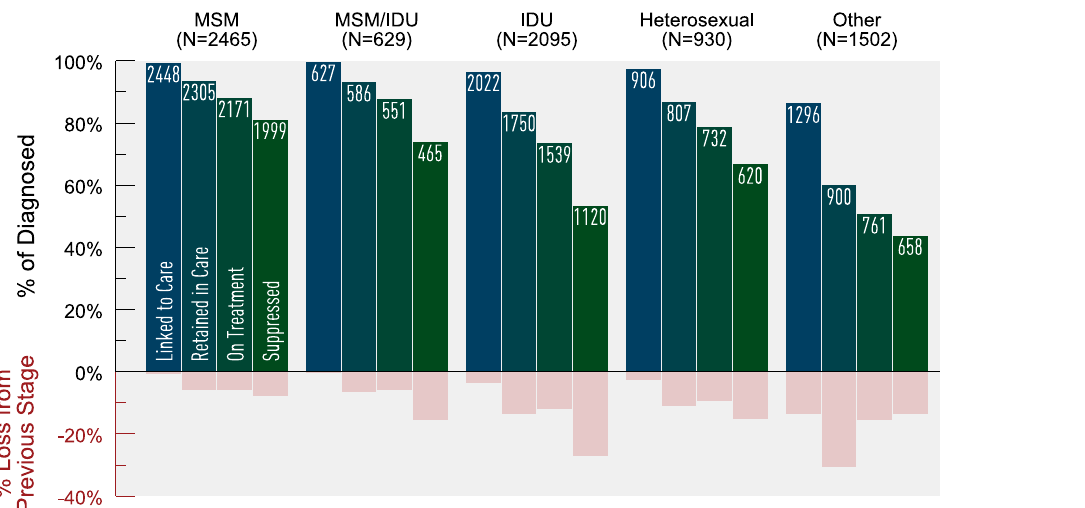
Fig. 4. Estimated HIV cascade of care by risk category in 2011 for British Columbia. *MSM 5 men who have sex men, IDU 5 history of injection drug use, MSM/IDU 5 both MSM and IDU, Other 5 blood transfusion or perinatal exposure or unknown risk group (i.e., risk factor not requested or